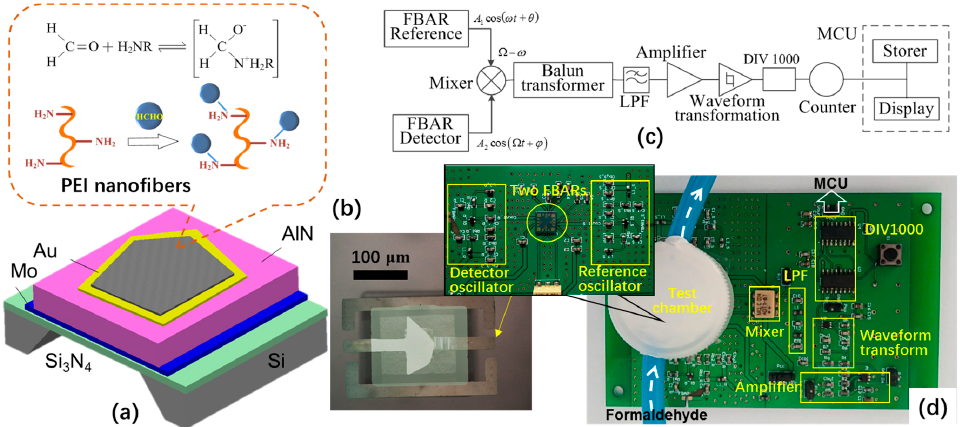
Figure 1. ( a ) Schematic structure and sensing mechanism of the film bulk acoustic resonator (FBAR) sensor coated with polyethyleneimine (PEI) nanofibers; ( b ) Photomicrograph of the fabricated device; ( c ) Block diagram of the testing system based on differential frequency processing; ( d ) Completed